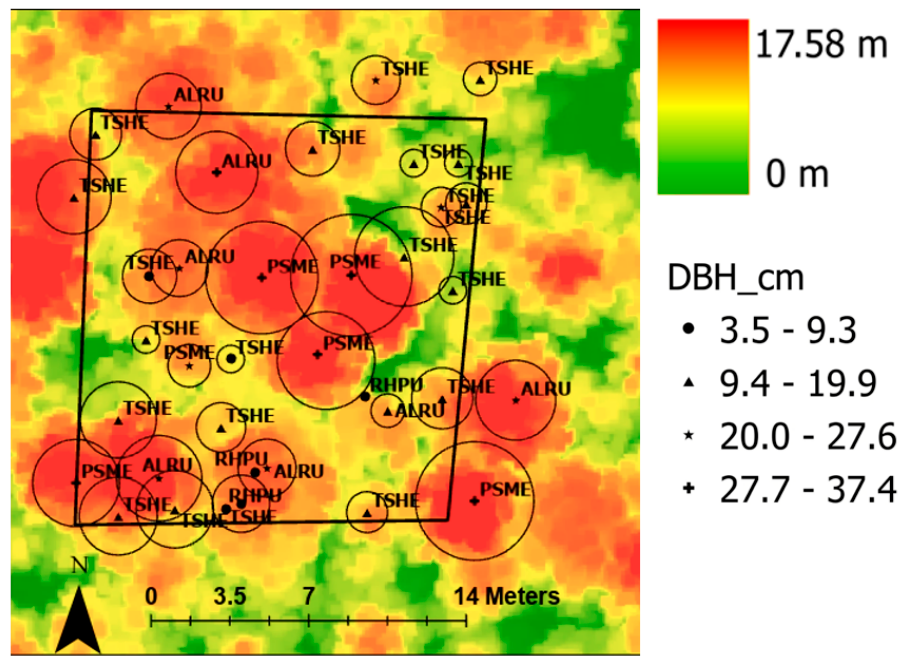
Figure 3. Stem map with circles representing each tree crown. The circle radii were determined using equation 1 and the field-measured height. Individual trees are represented as different symbols based on their DBH and labeled based on their USDA species code. Trees with their DBH in the two highest classes (20 cm and above) alone were used for matching the stem maps to the LiDAR CHMs. The tree plot corners and borders are also shown.